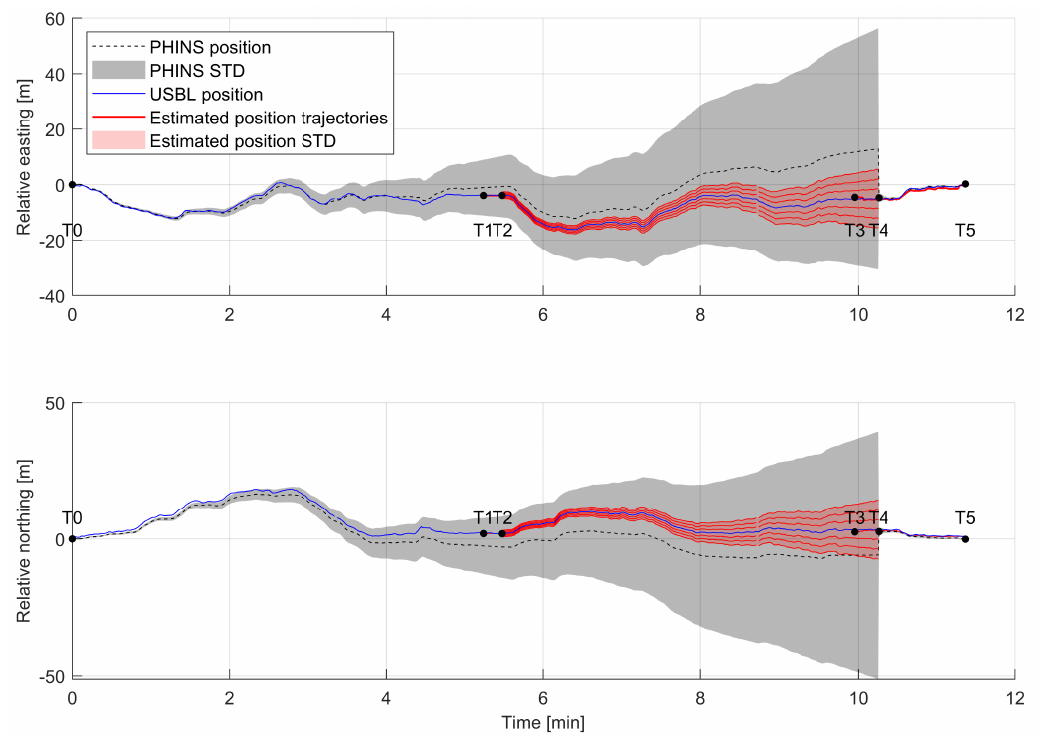
Figure 16. Family of position estimation trajectories (red continuous lines) from time T2 to T4 in case of ROV position update between time T1 and